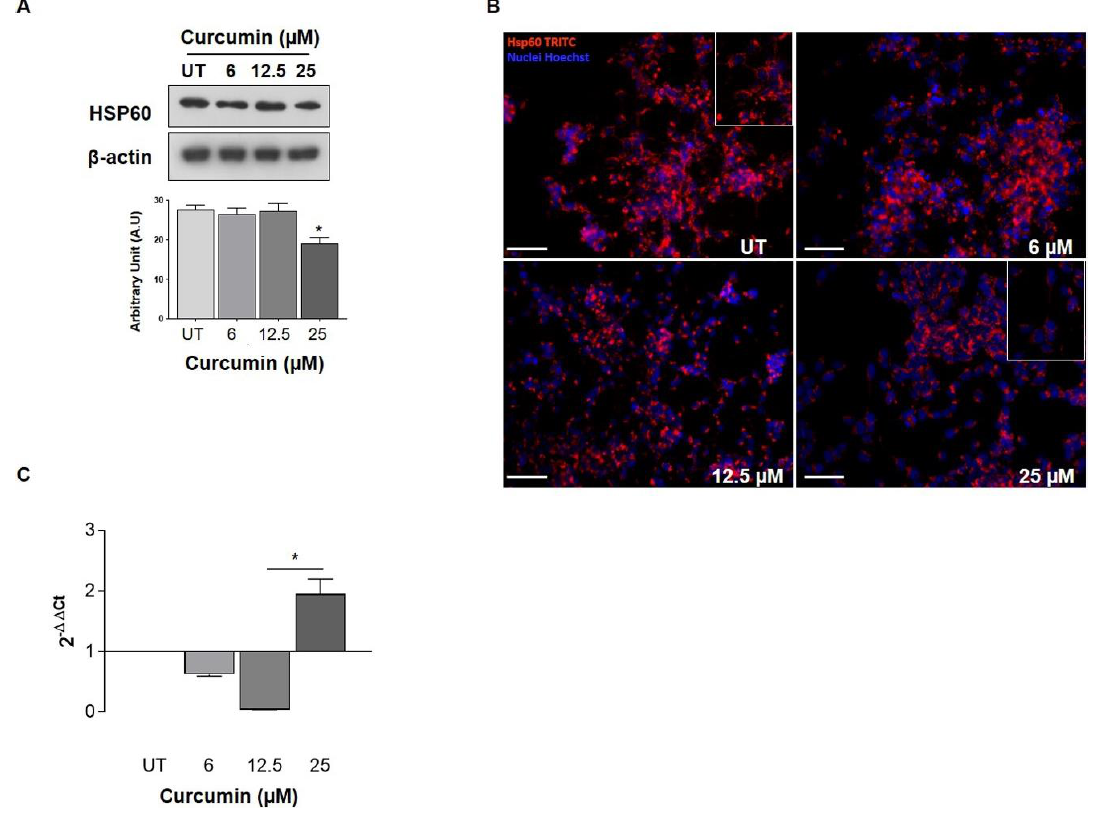
Figure 2. E ff ect of curcumin treatment on HSP60 expression level ( A ) Representative Western blots and graph of densitometry of the corresponding bands for HSP60 protein expression level in UT, 6 µ M, 12.5 µ M, and 25 µ M of curcumin. β -actin was used as an internal control (* Di ff erent than UT, 6 µ M, and 12.5 µ M, p < 0.01). Statistical analysis was performed using ANOVA analysis of variance followed by a Bonferroni post-hoc test. Experiments were performed in quadruplicate. ( B ) Immunofluorescence images confirming the data (Bar: 30 µ m). The chaperonin seems to be confined to mitochondria. The insets were obtained using the NIH Image J 1.40 analysis program (National Institutes of Health, Bethesda, MD, USA). ( C ) Representative graph showing real-time PCR analysis of HSPD1 , (heat shock protein family D, HSP60 member 1) gene expression. The data were normalized to reference genes according to the Livak Method (2 - ∆∆ Ct ). ( * Di ff erent than UT p < 0.05).